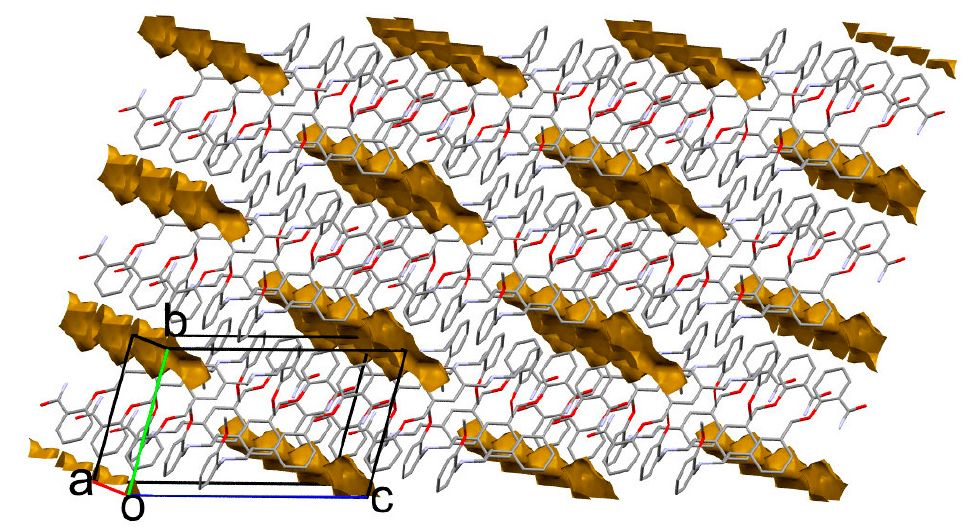
Figure 9. Packing of molecules in 1-MeOH crystal. The closed voids (brown shapes) indicate the solvent accessible volume. Hydrogen atoms are omitted for clarity.